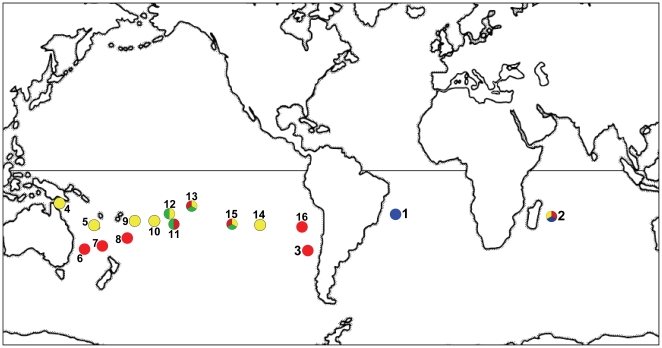
Distribution of selected Pterodroma petrels.
P. arminjoniana (blue1, 2), P.
neglecta (red2, 3, 6, 7, 8, 11, 13, 15, 16), light
morph P. heraldica (yellow2, 4, 5, 9, 10, 12, 13, 14,
15) and P. atrata/dark morph P.
heraldica (green11, 12, 13, 15).
1Trindade Island, 2Round Island, 3Juan
Fernandez, 4Raine Island, 5New Caledonia,
6Lord Howe Island, 7Phillip Island,
8Kermadec Islands, 9Tonga, 10Cook Islands,
11Australs, 12French Polynesia,
13Tuamotus, 14Easter Island, 15Pitcairn
Islands (including Henderson and Ducie), 16Desventuradas.